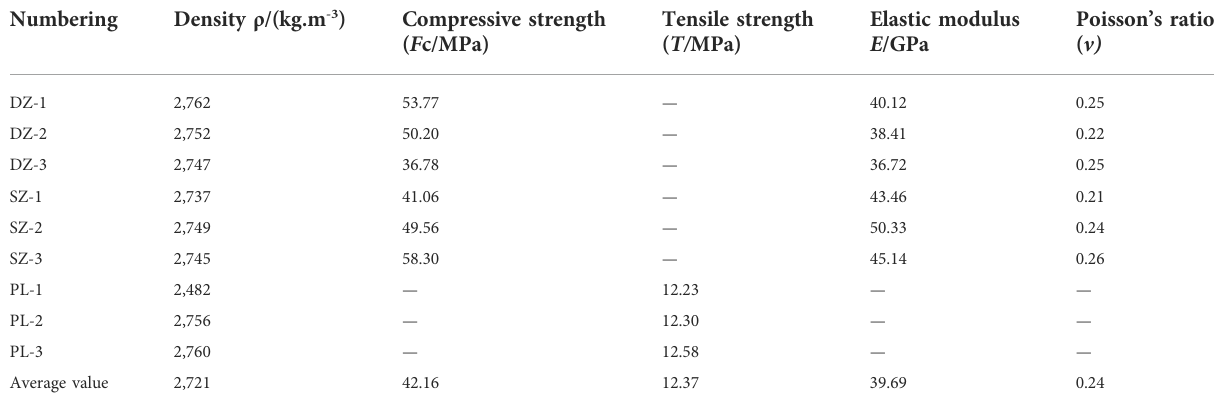
TABLE 2 Mechanical parameters of